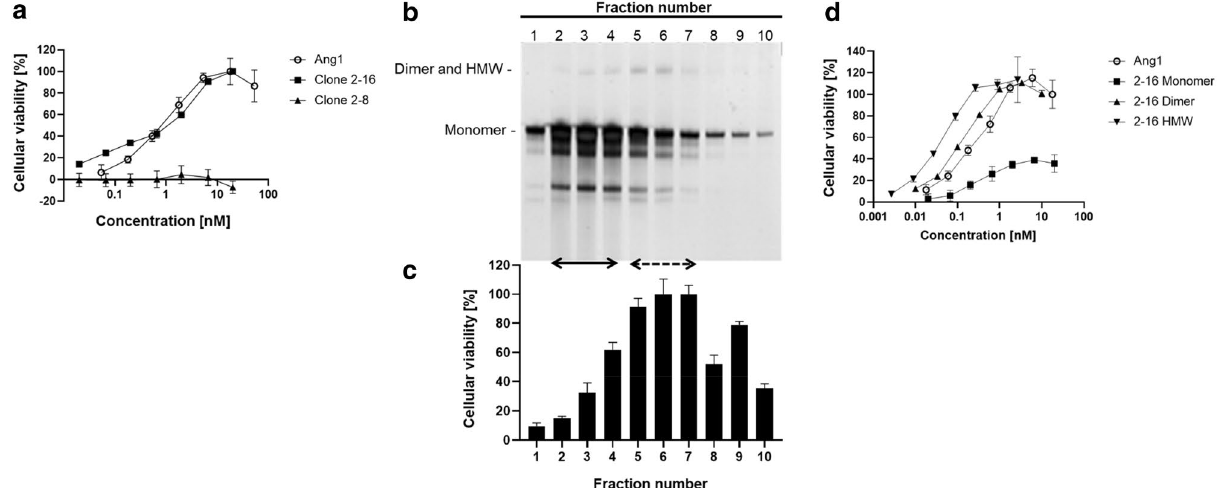
Figure 1. Characterization of newly identified anti-Tie2 agonistic antibodies. ( a ) Cellular viability as an indicator of agonistic activity of anti-Tie2 antibodies produced by hybridoma clones 2–16 and 2–8 were assessed in human Tie2-expressing Ba/F3 compared to Ang1. Cellular viability (%) was determined using a CellTiter-Glo assay, with basal activity without any ligand (PBS) defined as 0%, and the activity of 17.9 nM (1 µg/mL)